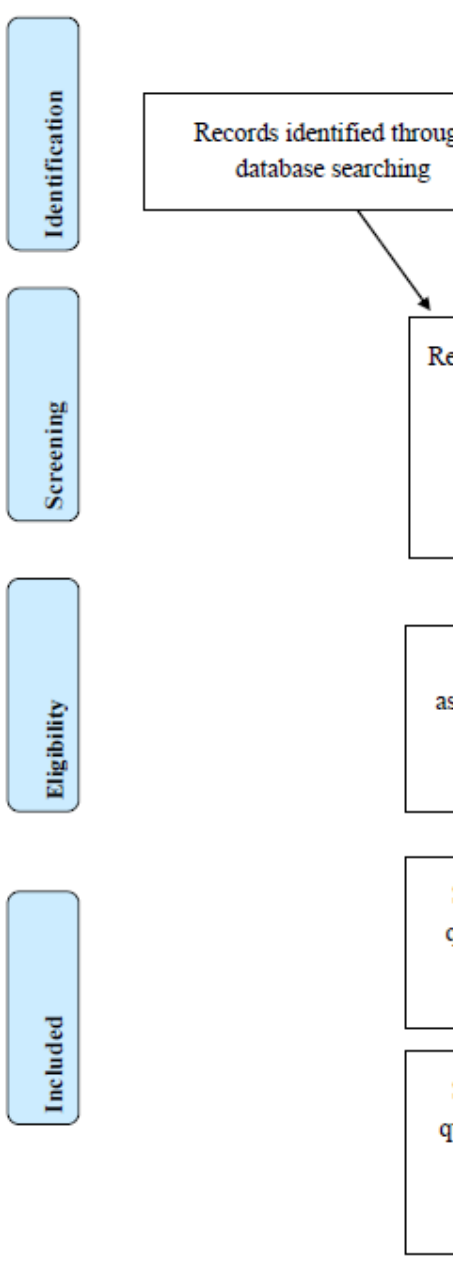
Figure 1. Flow diagram ( Adapted from : Moher, D., Liberati, A., Tetzlaff,